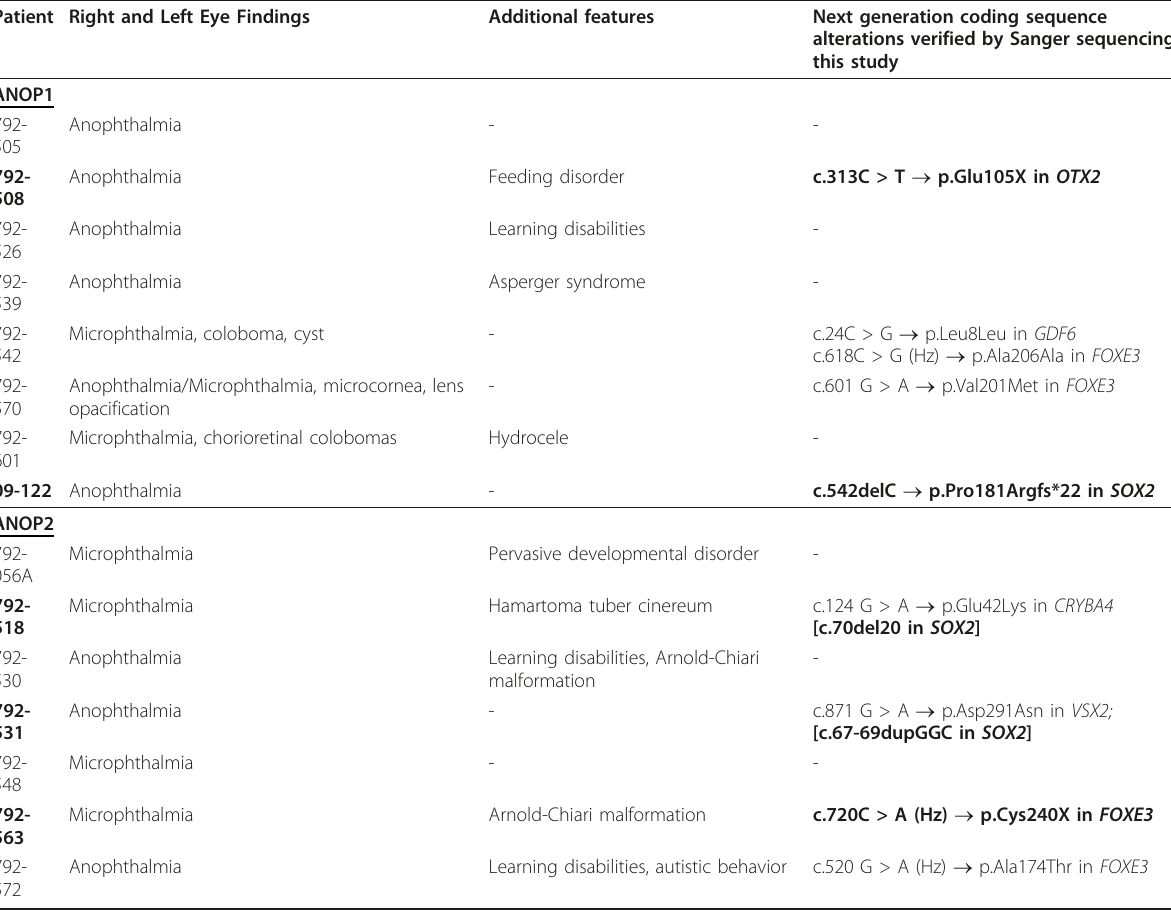
Table 2 Summary of Ocular Phenotypes and Next-Generation Sequencing Results in Two Patient Groups Patient Right and Left Eye